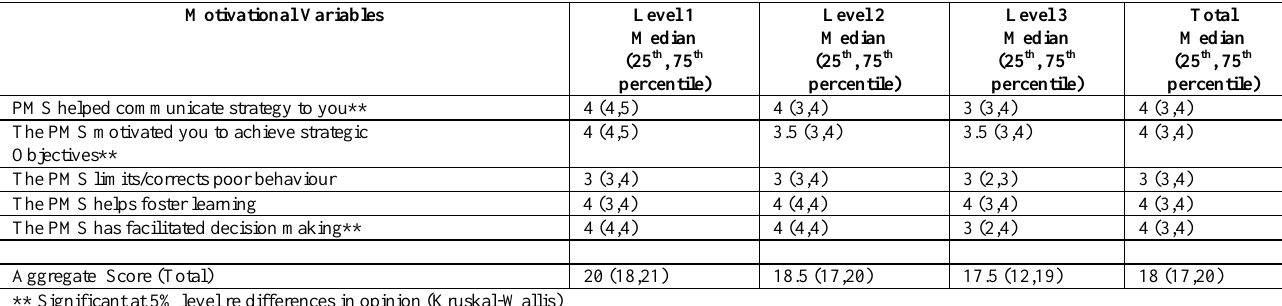
Table 5: Motivation across employee levels